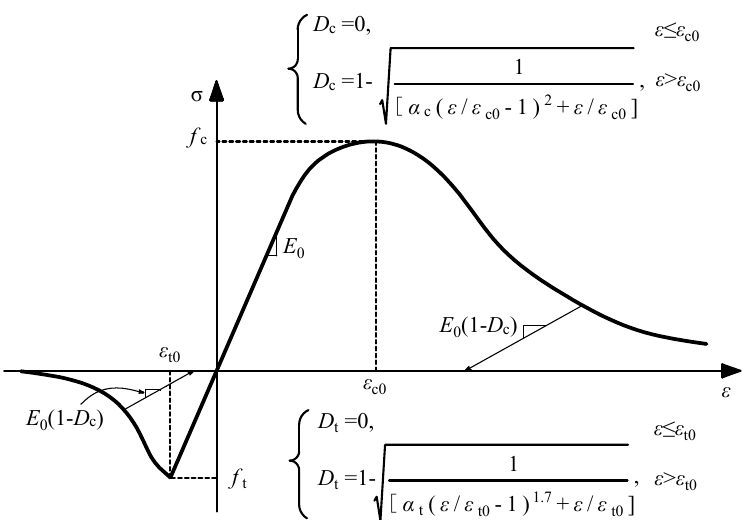
Figure 3. The damage evolution rules of stress-strain laws in the CDP (concrete damaged plasticity) model.